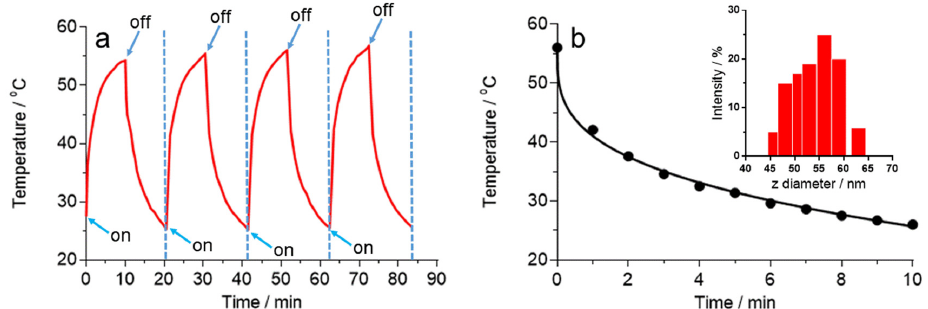
Figure 5. Photothermal stability of IONs. ( a ) Plot of temperature change of the IONs in water over four on/off cycles of 1064 nm laser irradiation; the temperature increased from an ambient value of 25 °C to an equilibrium value of 56 °C during continuous irradiation for 600 s. ( b ) Plot of temperature decay during the cooling period. Inset: Size distribution of IONs after being submitted to the four irradiation